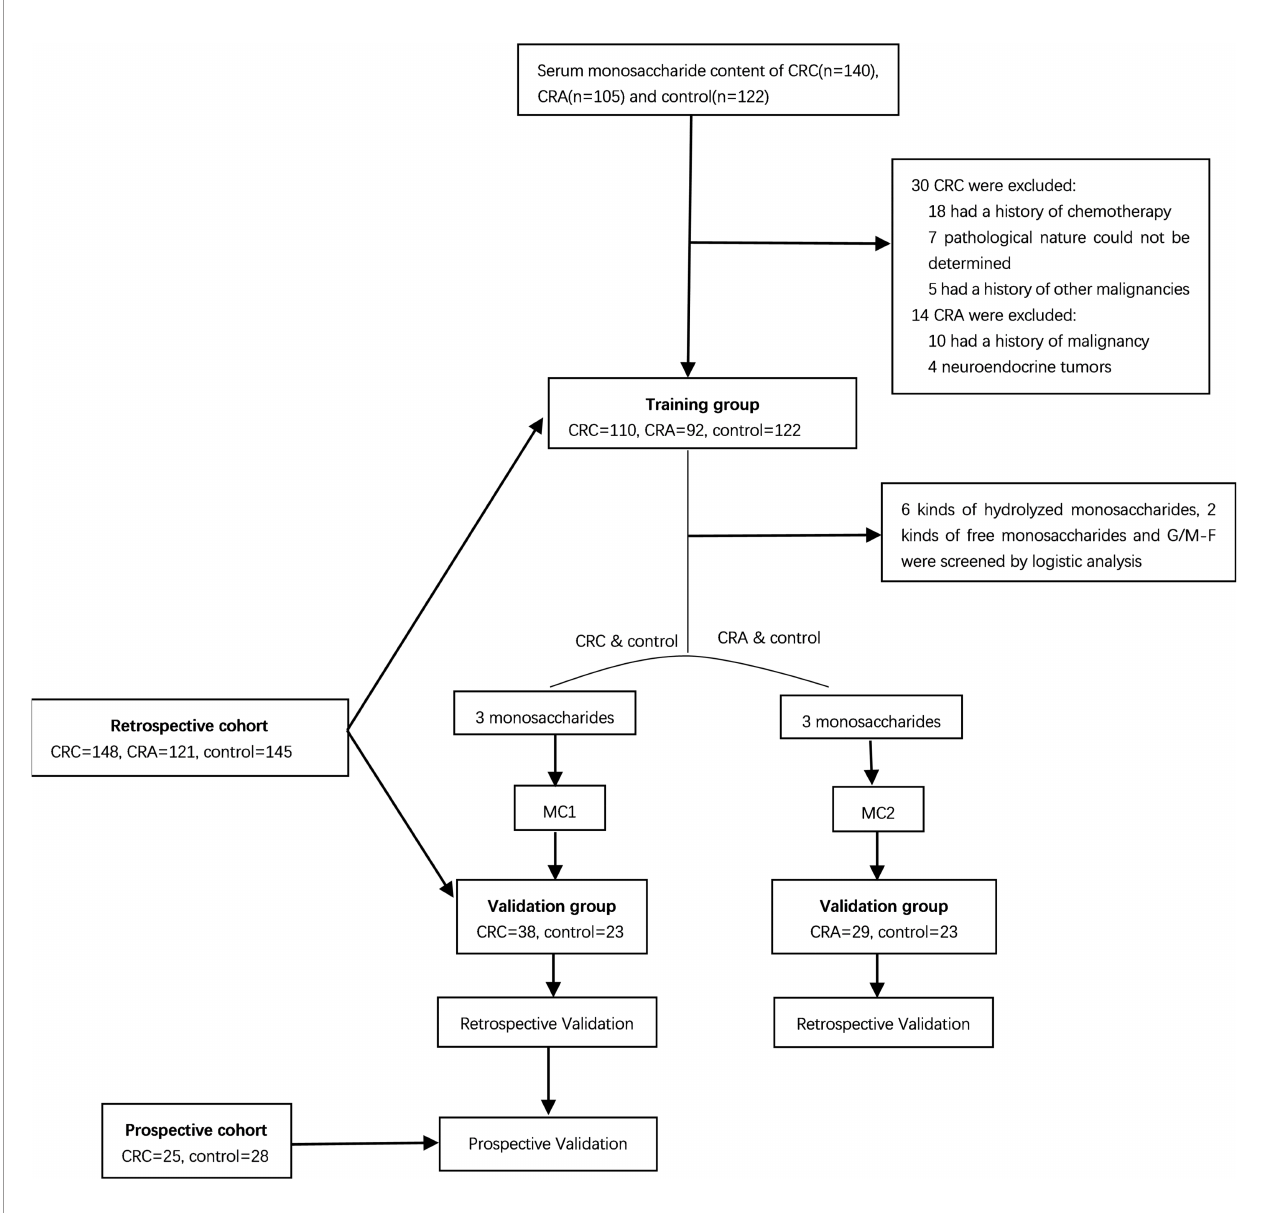
FIGURE 1 | Work fl ow of the